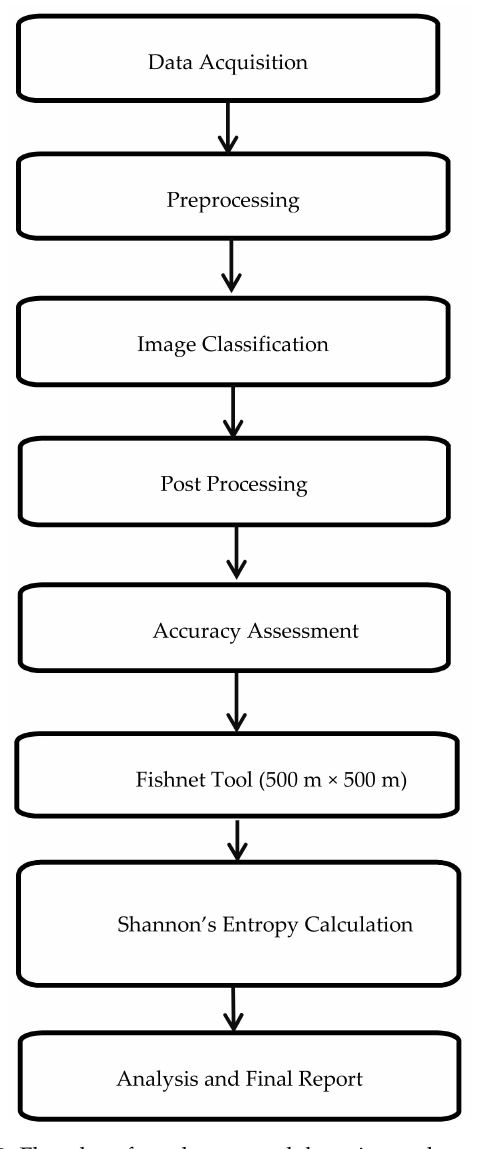
Figure 2. Flowchart for urban sprawl detection and